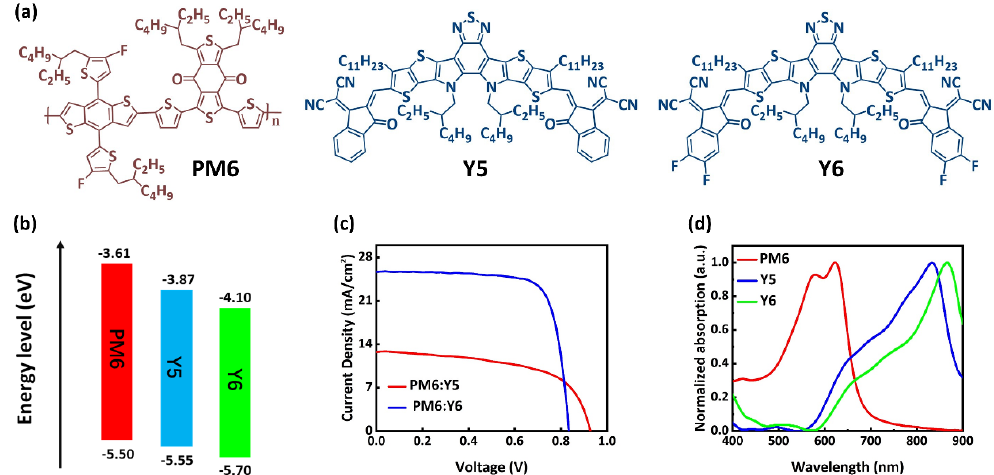
Figure 1. ( a ) Chemical structures and ( b ) energy level diagrams of donors (PM6) and acceptors (Y5 and Y6); ( c ) J − V characteristics of the PM6:Y5 and PM6:Y6 BHJ solar cells under 1 − Sun illumination; and ( d ) normalized absorption spectra of PM6, Y5m and Y6. Table 1. The detailed photovoltaic parameters of the OPV cells. Active Layer